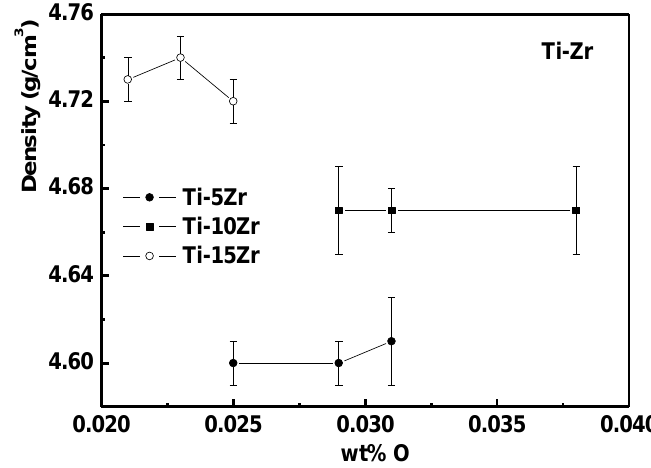
Figure 1. Density as a function of oxygen content in Ti-Zr